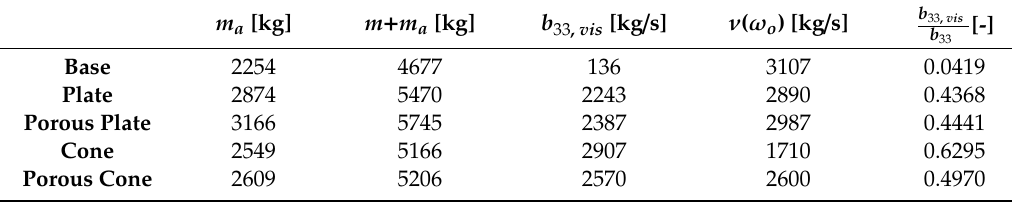
Table 4. Added mass, total mass, coefficients of viscous and radiation damping, and ratio of viscous damping to total damping of a lightweight light buoy from the potential ‐ based motion analysis.